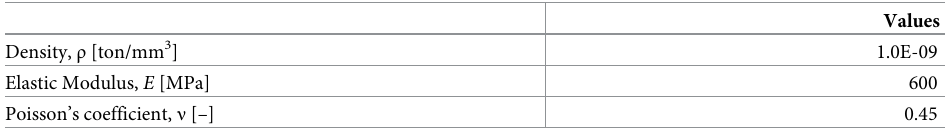
Table 3. Parameters used to describe the elastomeric material of the